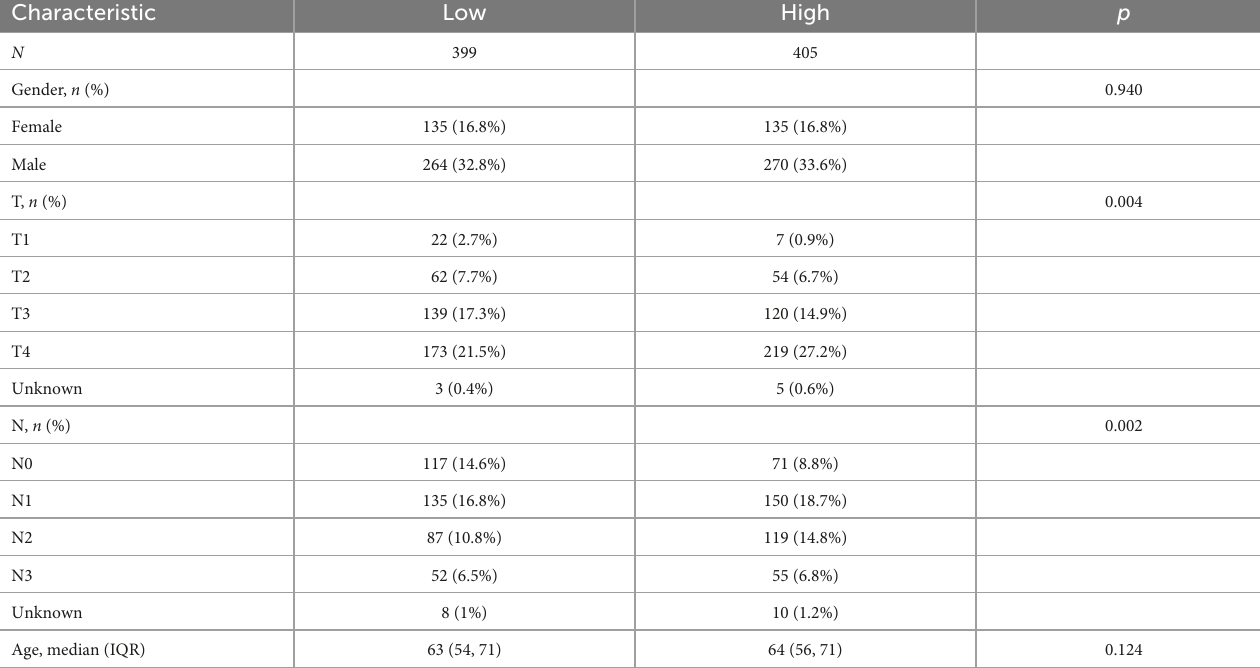
TABLE 3 The chi-square test of the relation between two risk groups and clinical features in cohort. Characteristic Low